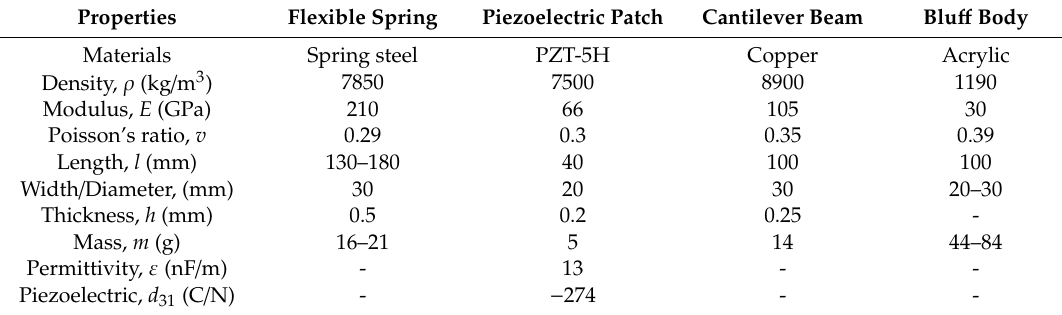
Table 1. Dimensions and materials parameters of the harvester system.